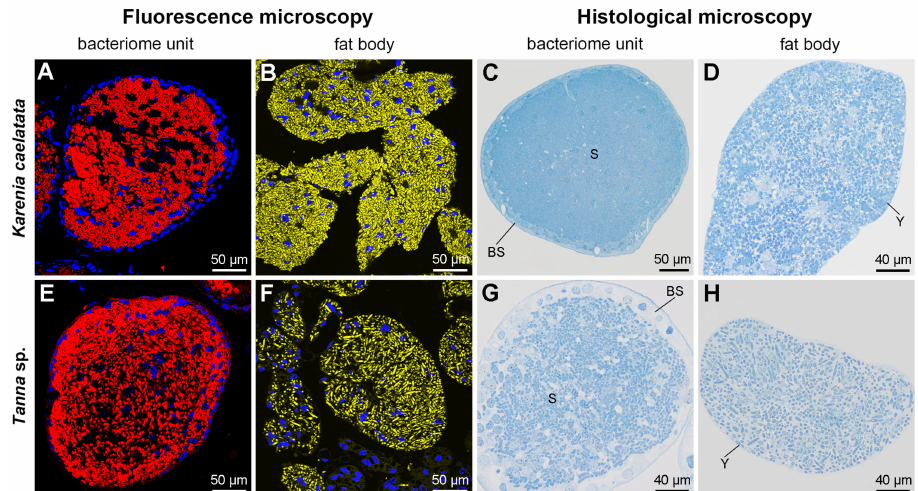
Figure 3. Histological and fluorescence microscopy showing the distribution of Sulcia and YLS in the bacteriomes and fat bodies of Karenia caelatata and Tanna sp. ( A – D ) Distribution of Sulcia and YLS in the bacteriomes and fat bodies of K. caelatata. ( E – H ) Distribution of Sulcia and YLS in the bacteriomes and fat bodies of Ta . sp. For fluorescence microscopy, blue, yellow, and red represent the nucleus, YLS, and Sulcia , respectively. Abbreviations: BS, bacteriome sheath; S, Sulcia ; Y, yeast-like fungal symbiont.